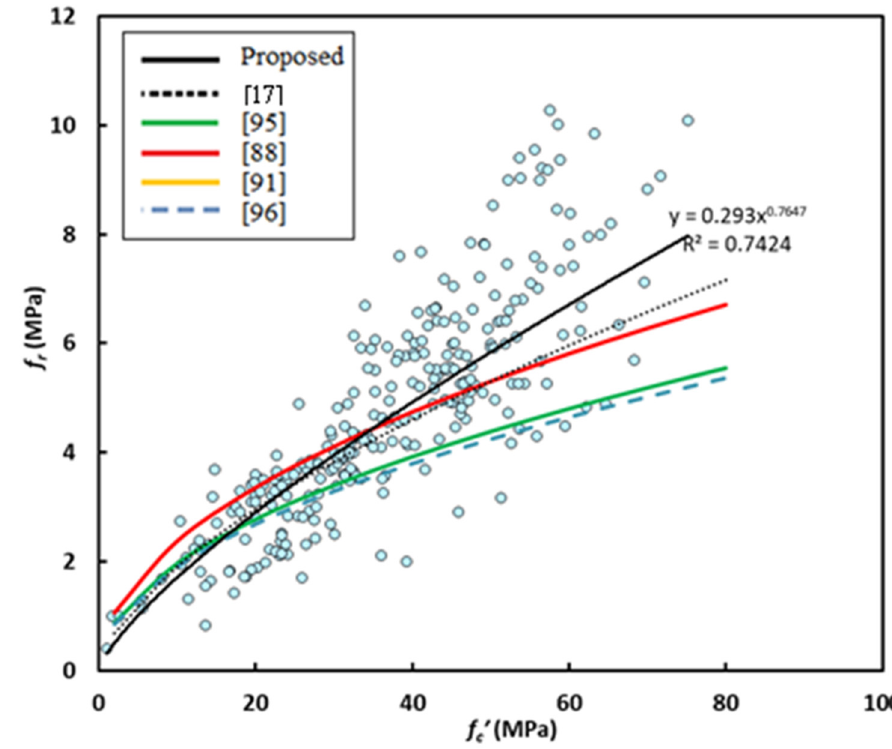
Figure 9. Flexural strength data scatter and proposed equations.